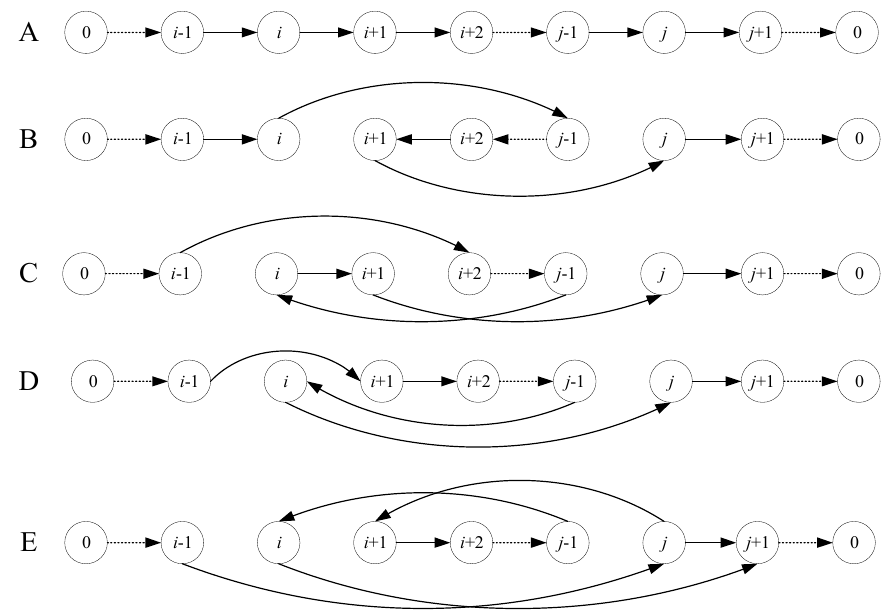
Figure 3. A is the initial solution, B is the result of 2-opt, C is the result of or-opt, D is the result of 1-relocate, E is the result of 1-exchange.